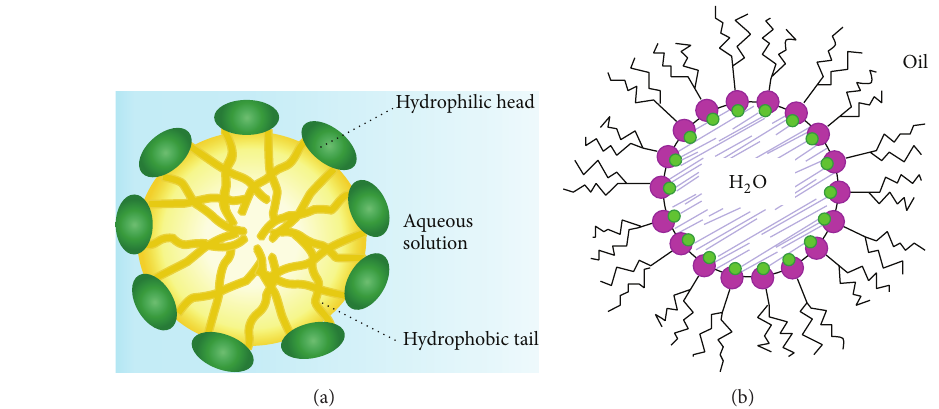
Figure 2: Typical structures of (a) micelle and (b) reverse